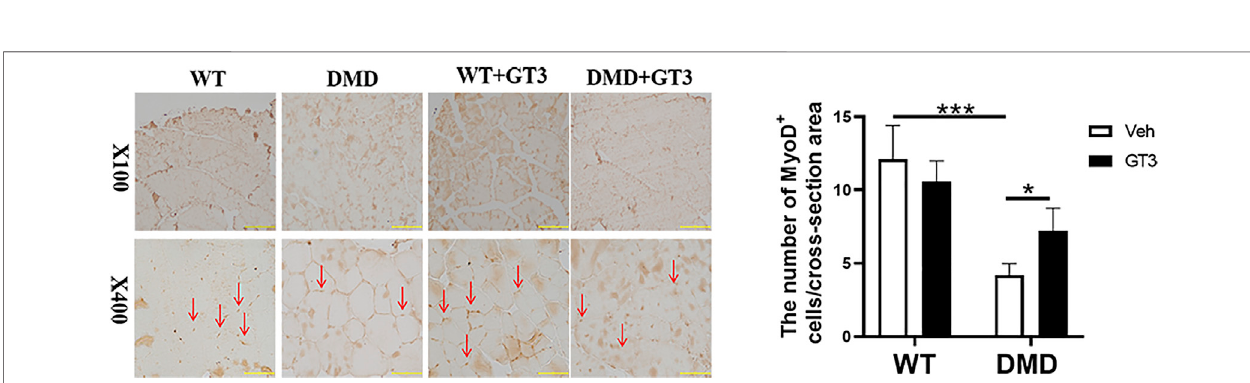
FIGURE8| Effects ofGT3on differentiation ofmuscle stemcells inDMDmice. Thetibialis anterior wasextracted 48 hafter GT3treatmentin 40-week-old WT and DMD mice. MyoD1 positive cells were stained with brown (red arrow, left panel). Numbers of MyoD1 positive cells were counted in each fi eld. Data were presented at means ± SEM ( n = 6) with two-way ANOVA analysis. * p < 0.05, *** p < 0.001.